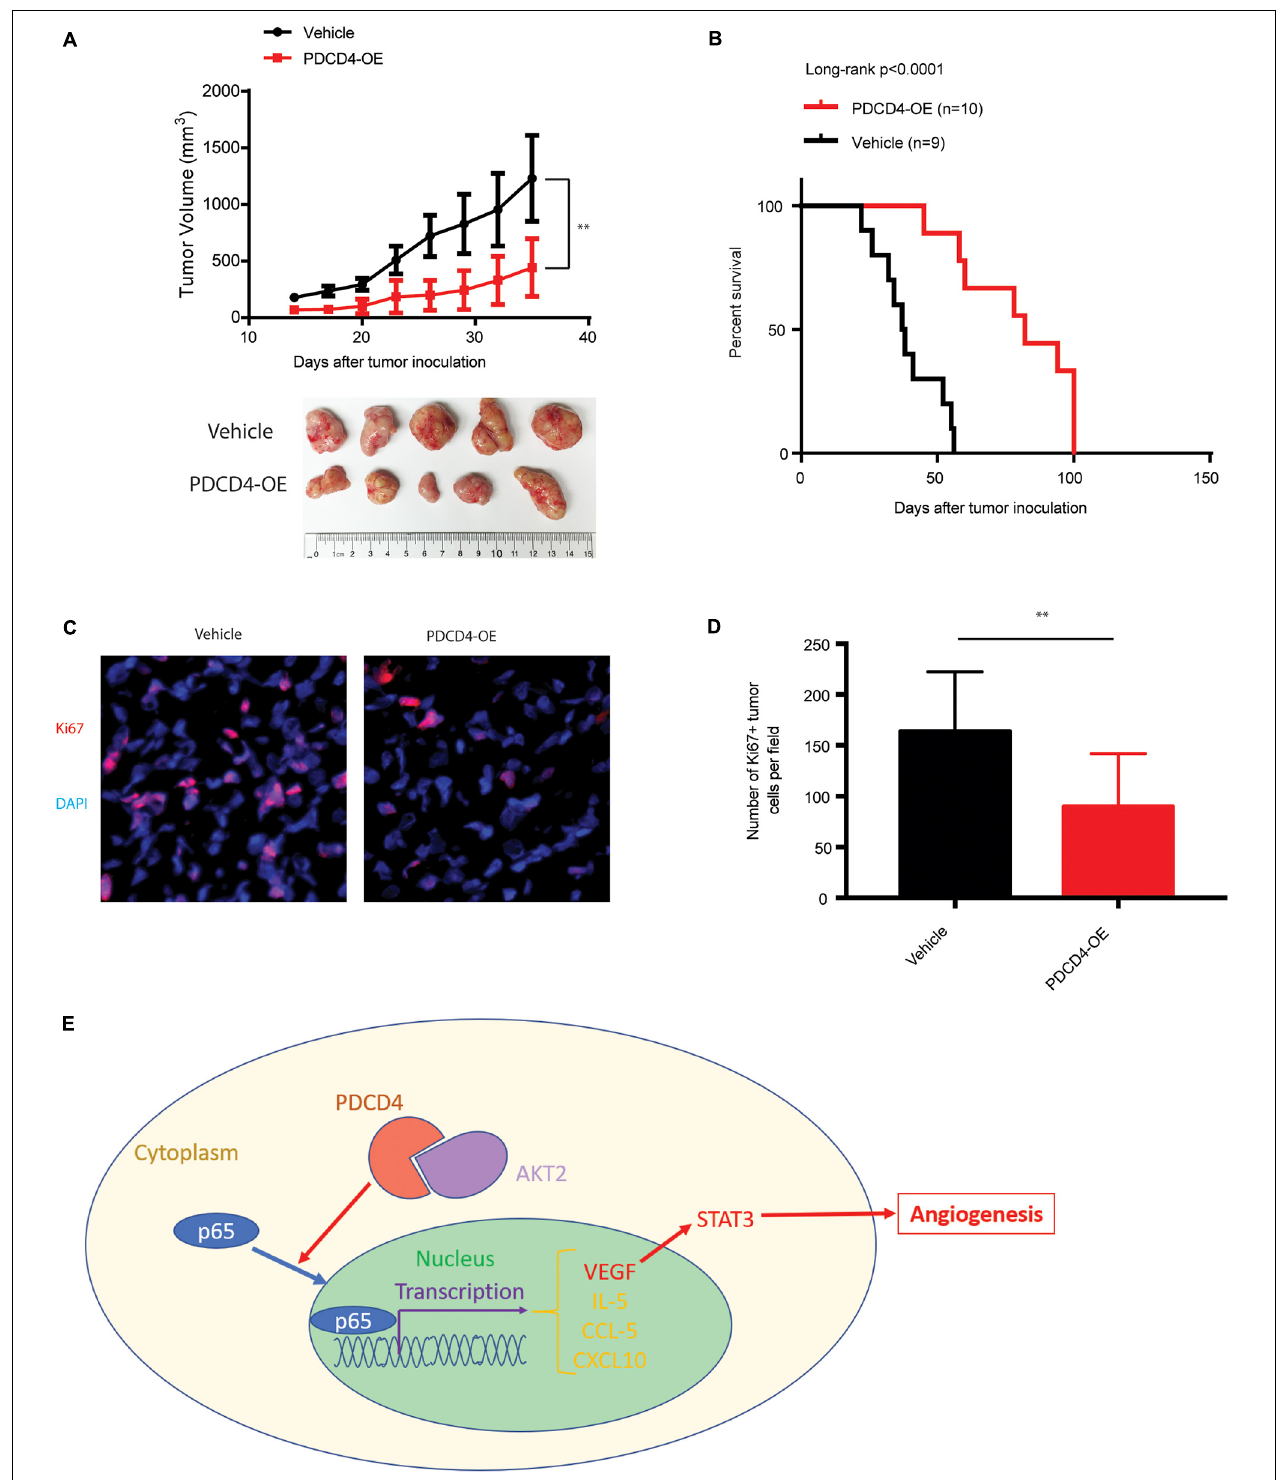
FIGURE 5 | Over-expression of PDCD4 impedes glioma tumorigenesis in vivo . (A) Growth kinetics of glioma cells stably over-expressing PDCD4 following subcutaneous inoculation in nude mice. (B) Kaplan-Meier survival curves of glioma cells stably over-expressing PDCD4 following subcutaneous inoculation in nude mice. (C) Representative immunofluorescence staining images of the indicated glioma tumors. (D) Quantification of Ki67 + proliferating cells in the indicated tumors. (E) Schematic of the proposed model depicting the binding of AKT2 and PDCD4 that regulates the nuclear translocation of p65, and thus leads to cytokine expression and angiogenic activity. ** P <